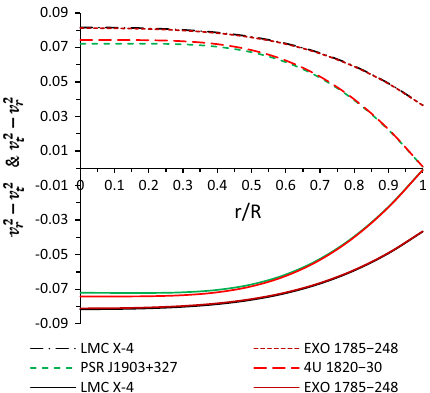
Fig. 9 Behaviour of v 2 r − v 2 t ( dotted line ) and v 2 t − v 2 r ( solid line ) vs. fractional radius r / R for LMC X-4, EXO 1785-248, PSR J1903+327 and 4U 1820-30. For plotting of this figure we have employed data set values of the physical parameters and constants which are the same as used in Fig.